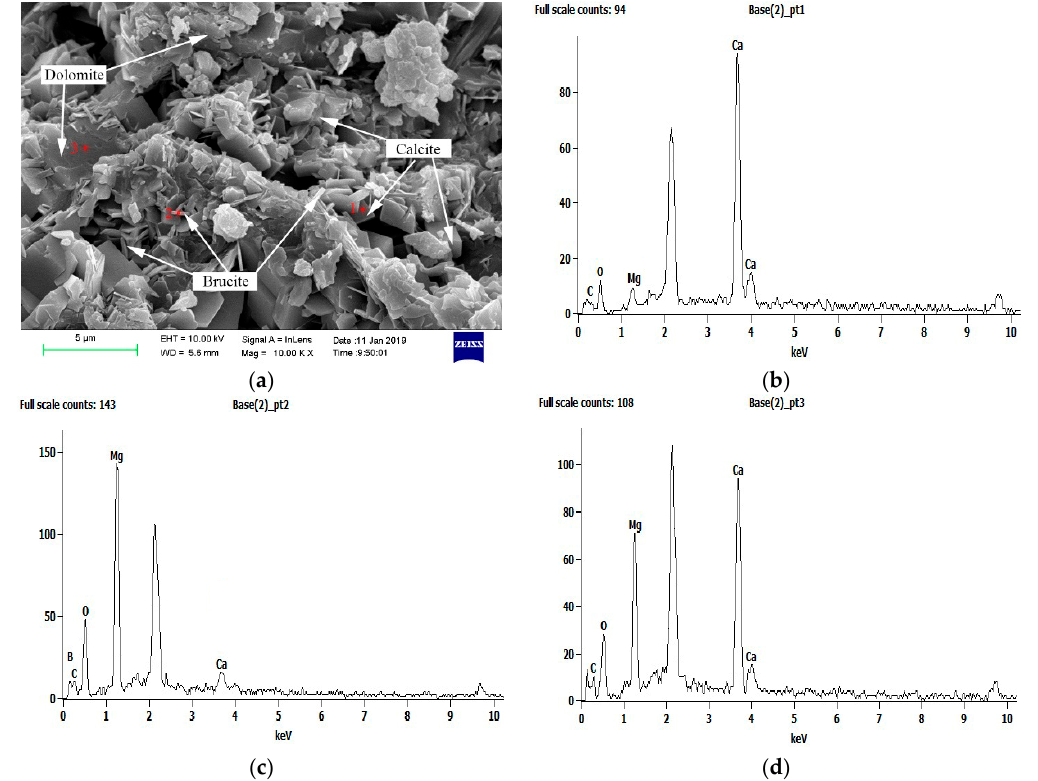
Figure 10. Scanning electron microscopy and energy dispersive spectrometry (SEM-EDS) analysis: ( a ) SEM image of reacted JT1 aggregate; ( b – d ) EDS images of calcite, brucite, and dolomite, respectively.